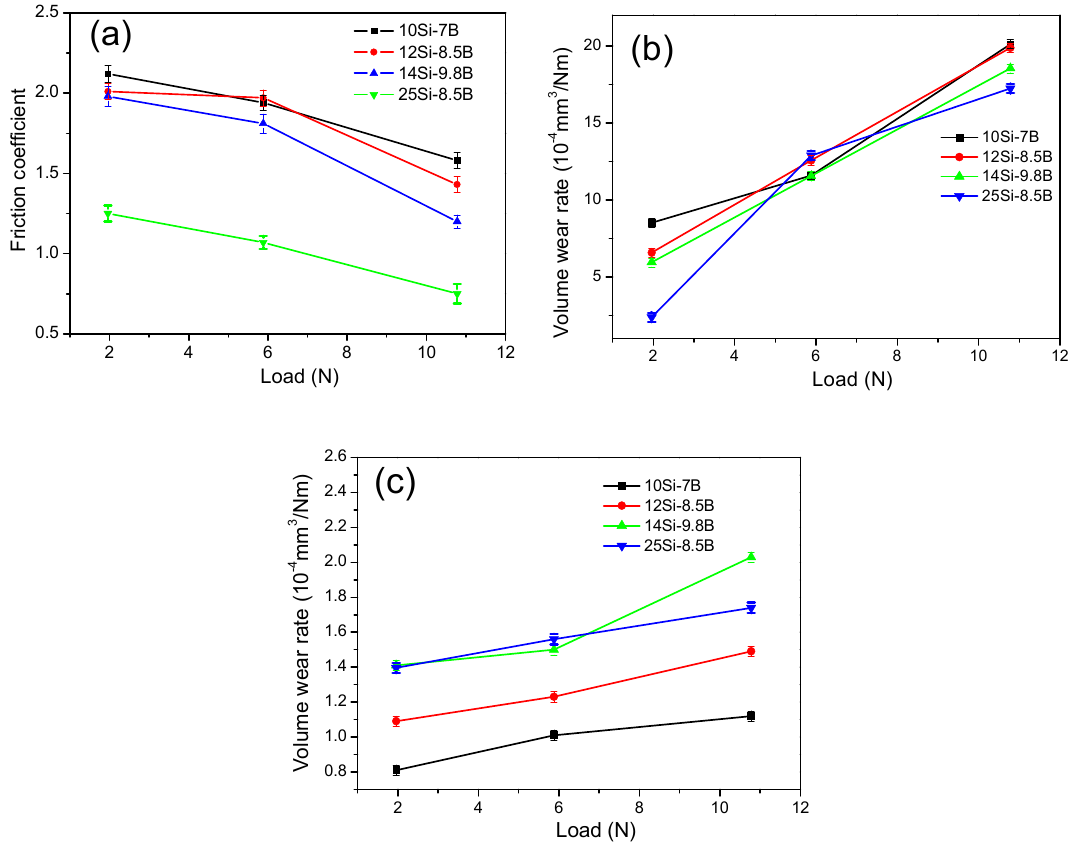
Figure 4. ( a ) Friction coefficients and ( b ) wear rate curves for Mo-Si-B alloy doped with 0.3 wt % La 2 O 3 plate specimens under different experimental loads and ( c ) wear rates of their paired Si 3 N 4 ball